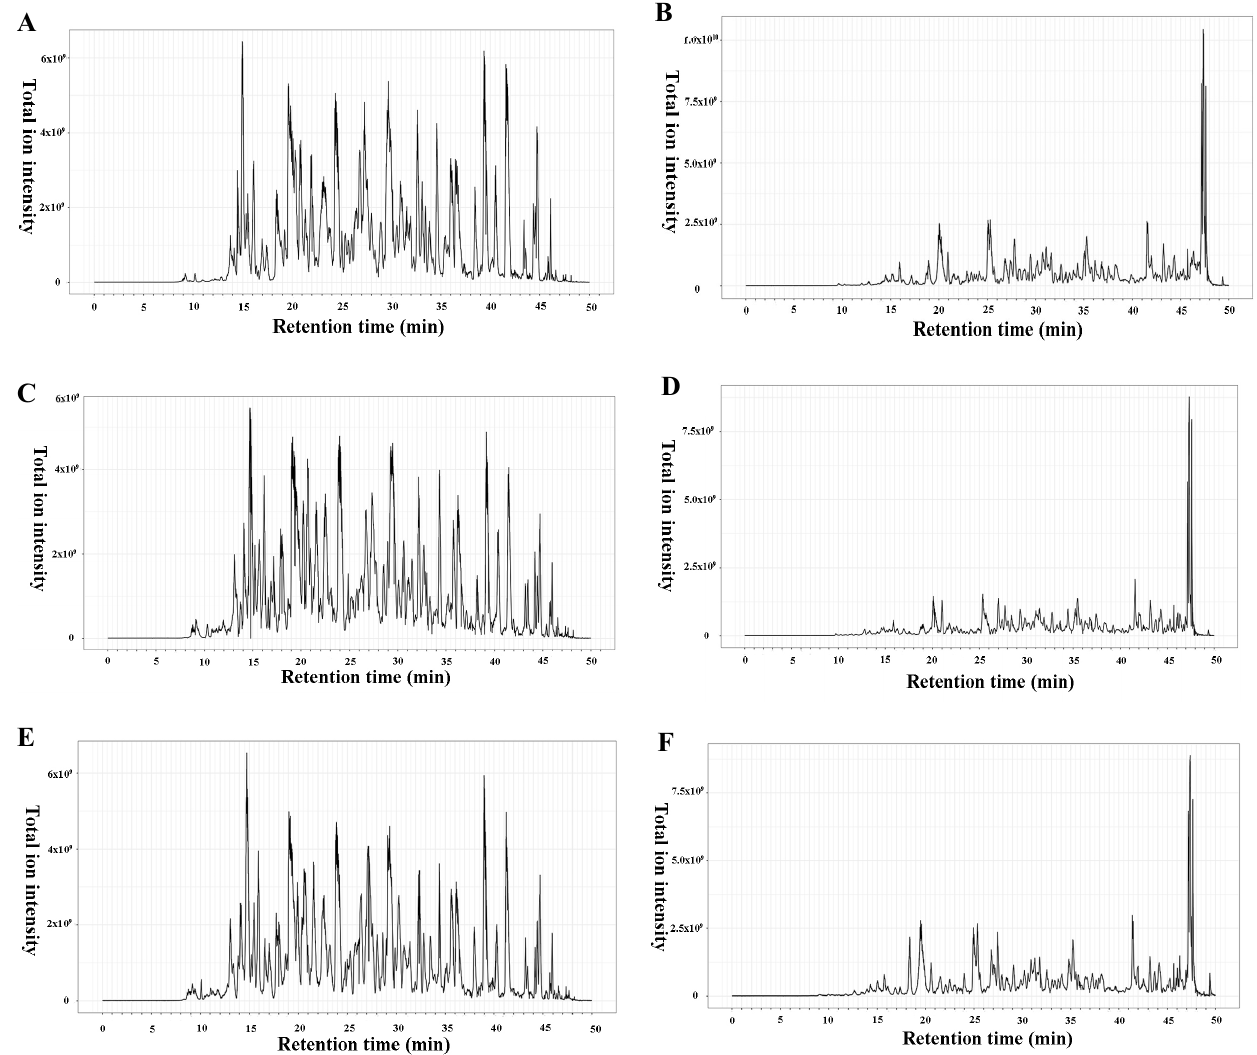
Figure 3. UPLC chromatograms for the peptide profiles in the digests of bLf ( A , B ), LfPF complex ( C , D ), and LfPFTG complex ( E , F ) after in vitro gastric (pepsin) digestion ( A , C , E ) and gastrointestinal (pepsin + trypsin) digestion ( B , D , F ).